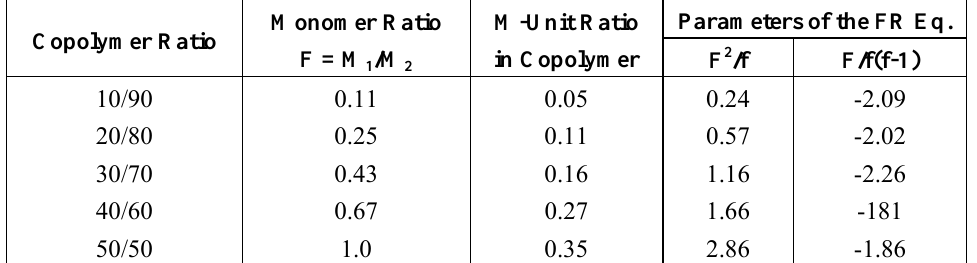
Table 2. The monomer reactivity ratios and the FR parameters of poly(DTBTC- co -VI) ( II ).